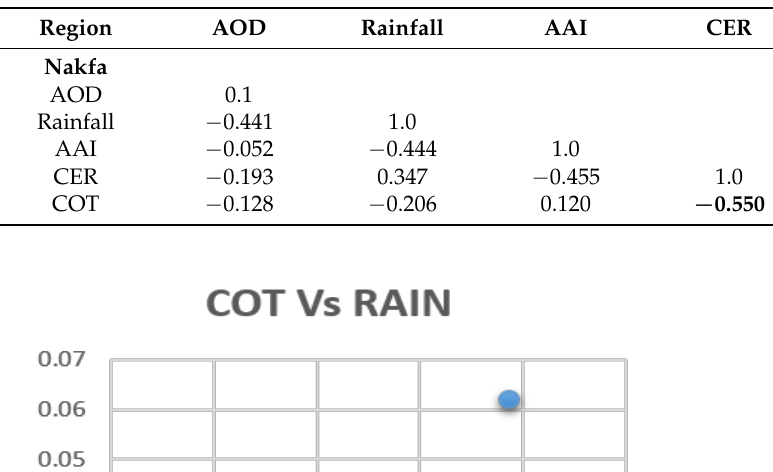
Table 9. The correlation coefficient values between AOD, rainfall, AAI, CER, and COT over Nakfa in JJA between 2001 and 2018. The correlation coefficient (R) values ≥ 0.468 (critical R-value) are highlighted in bold.